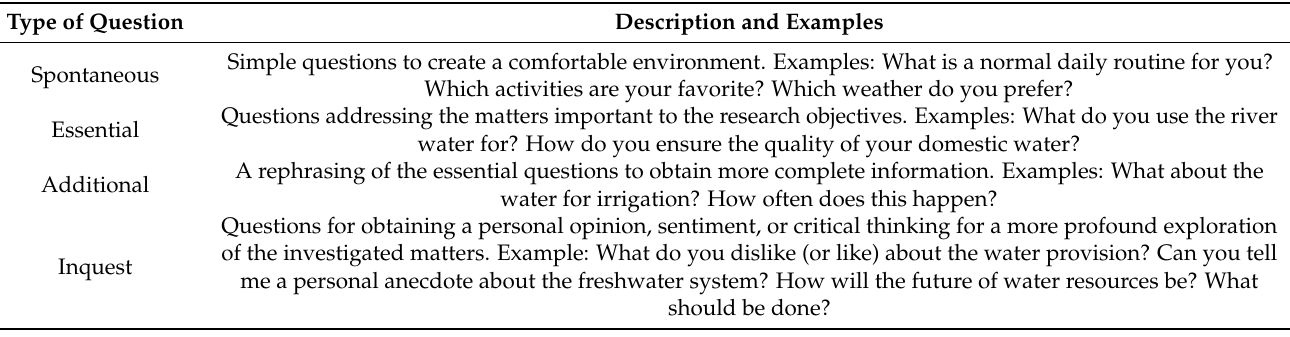
Table A1. Guidelines * for conducting the semi-structured